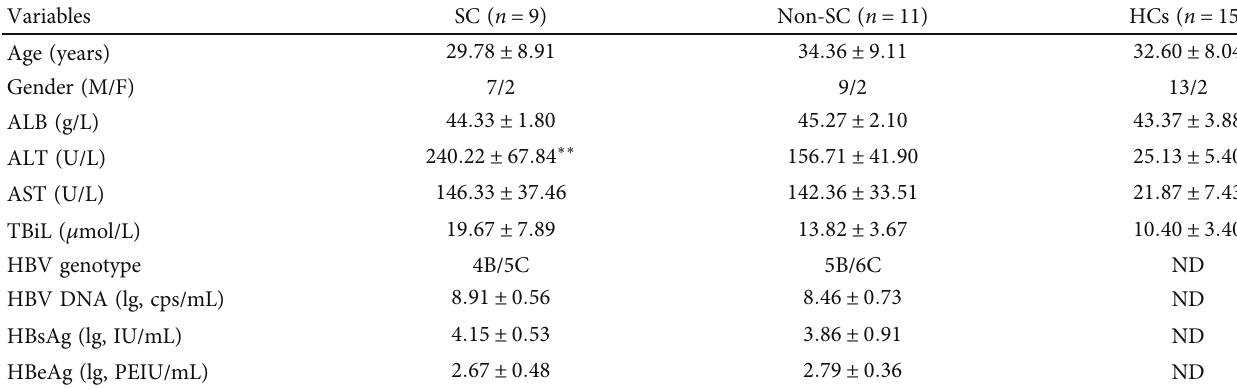
Table 1: Clinical and virological parameters in enrolled subjects at baseline.